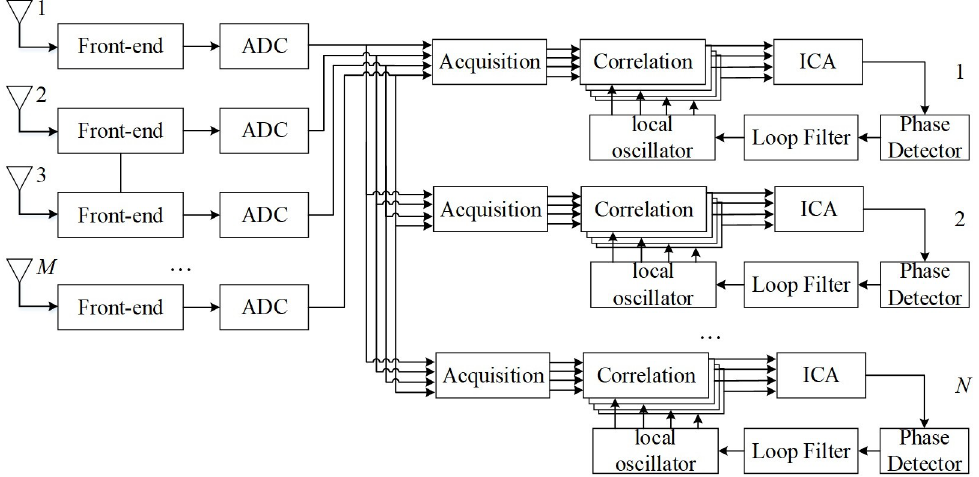
Fig 1. Diagram of the postcorrelation ICA algorithm for array satellite navigation